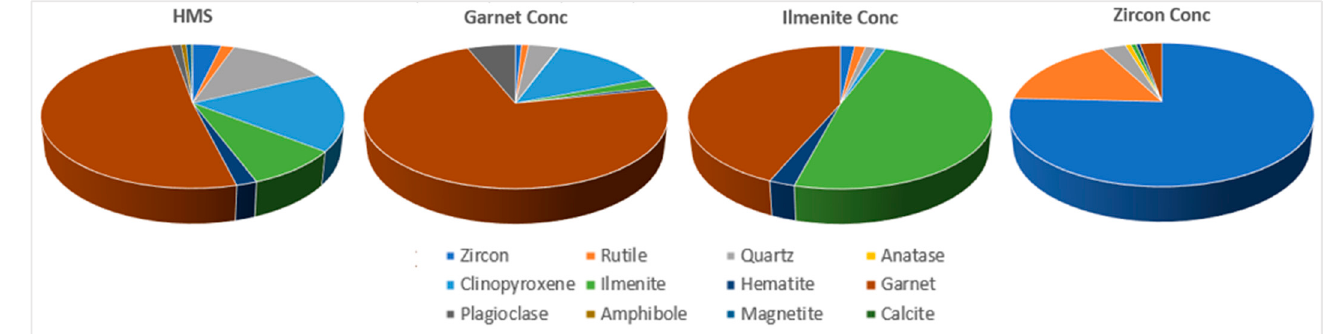
Table 1. Average mineral abundancies (weight%) of 25 weekly composite samples each, and target values.